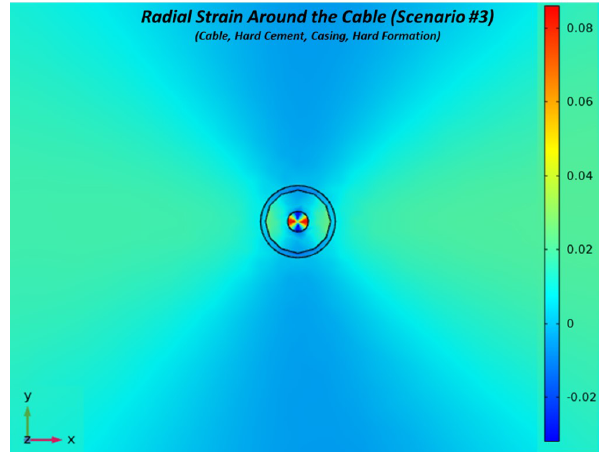
Figure 9. Radial strain around the cable as a response of compres- sional wave propagation at a 90 ◦ incident angle in scenario 5 (inci- dent waveform is incoming from the right).